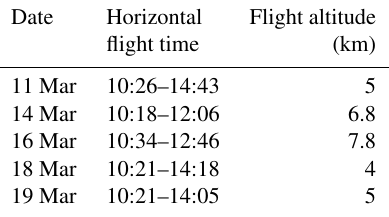
Table 2. Details of flight on each